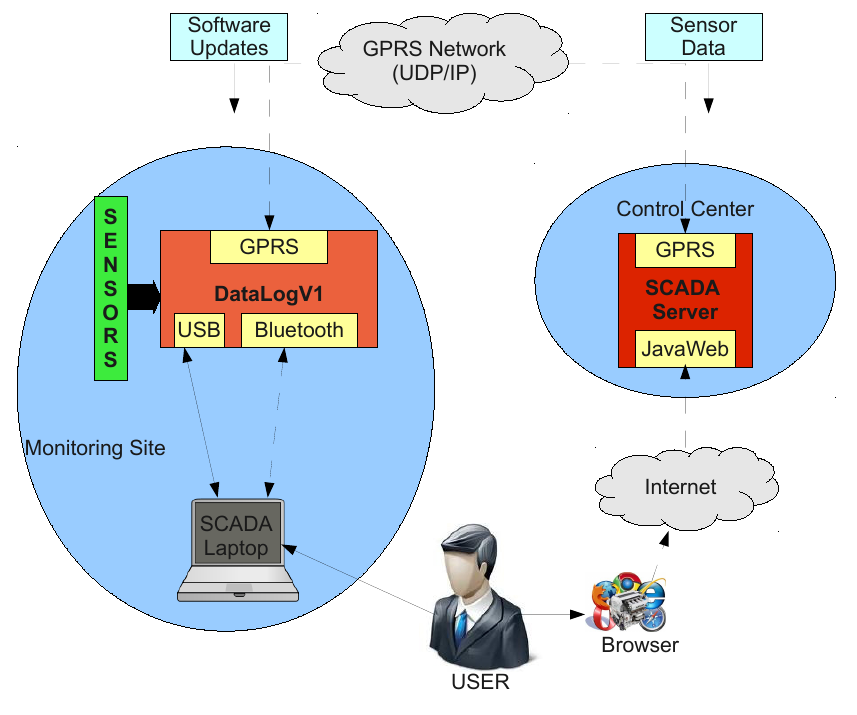
Figure 13. Monitoring system based on remote DatalogV1 and SCADA